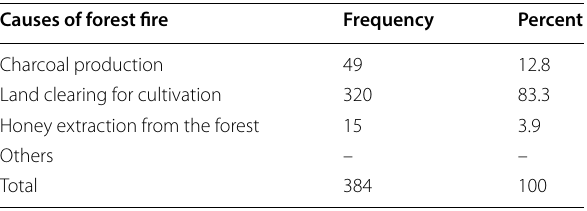
Table 13 Causes of forest fire in Chewaka district.